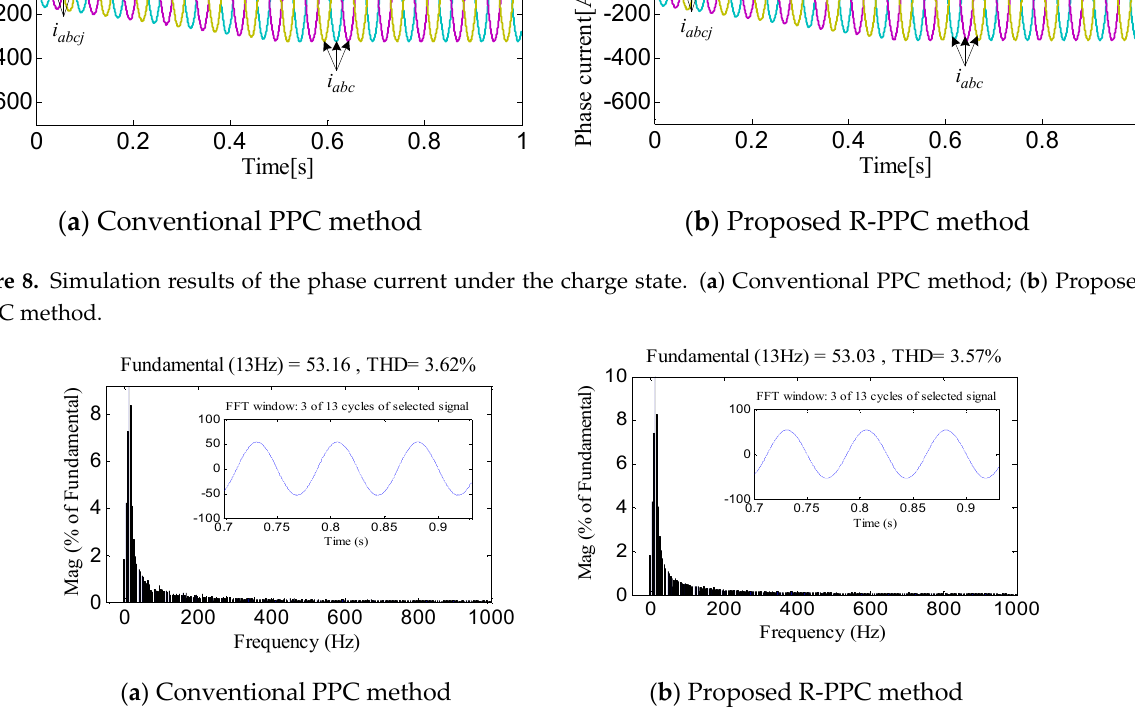
Figure 9. Stator current frequency spectra of the unit motor under the charge state. ( a ) Conventional PPC method; ( b ) Proposed R-PPC method.